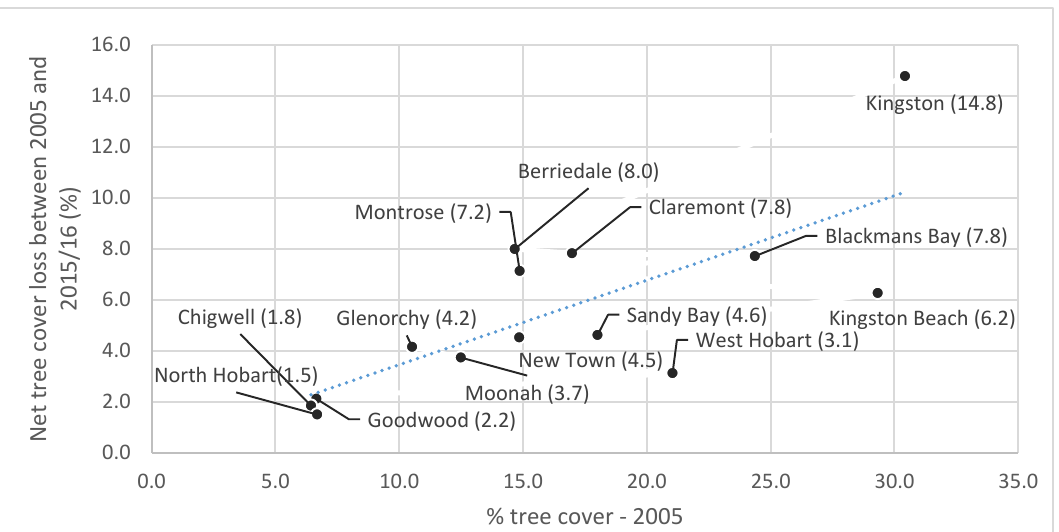
Figure 12. Percentage tree cover in 2005 versus net tree cover losses between 2005 and 2015/16 with fourteen sample patches with four hectares of area each (equation of trendline: net tree cover losses between 2005 and 2015/16 = 0.3318 tree cover (2005) + 0.138; R 2 = 0.55).